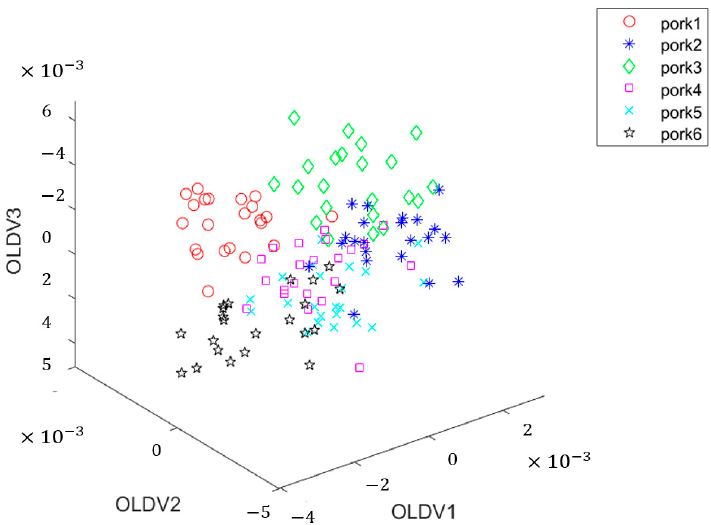
Figure 2. The score diagram of the three optimal discriminant vectors of OLDA.